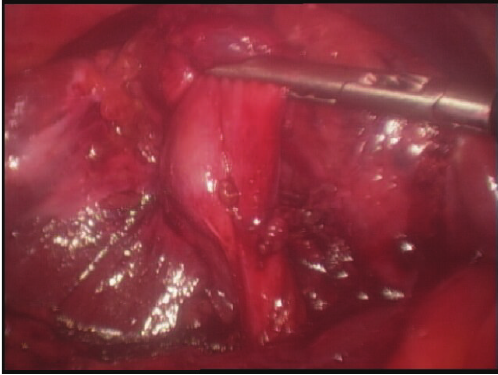
Figure 3: Careful dissection has presented the gallbladder remnant.